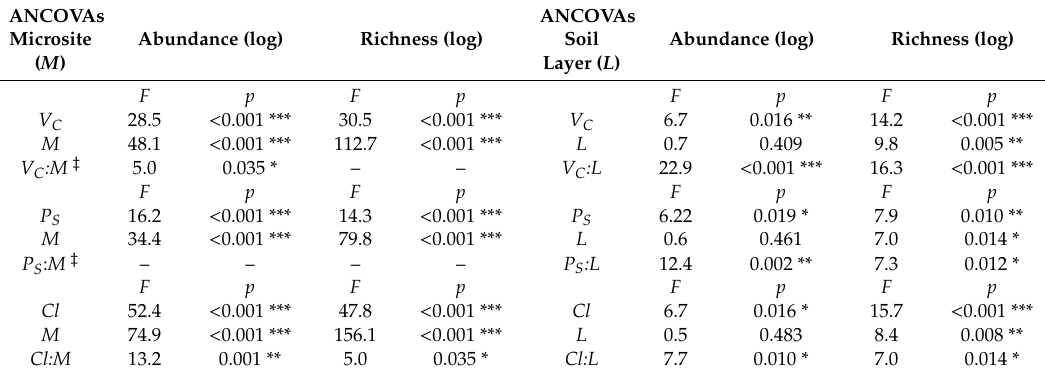
Table 1. Results ( F and p values) of ANCOVAs on landscape-scale (plot) abundance and species richness of ground arthropods as a function of the factor Microsite, M (patch and inter-patch), or Soil layer, L (litter and soil) and of di ff erent vegetation pattern covariables: V C , Vegetation cover; P S , average patch size; Cl : closeness (inverse of distance between patches); n = 14; *, **, ***: significant at 5%, 1%, and 0.1%, respectively.